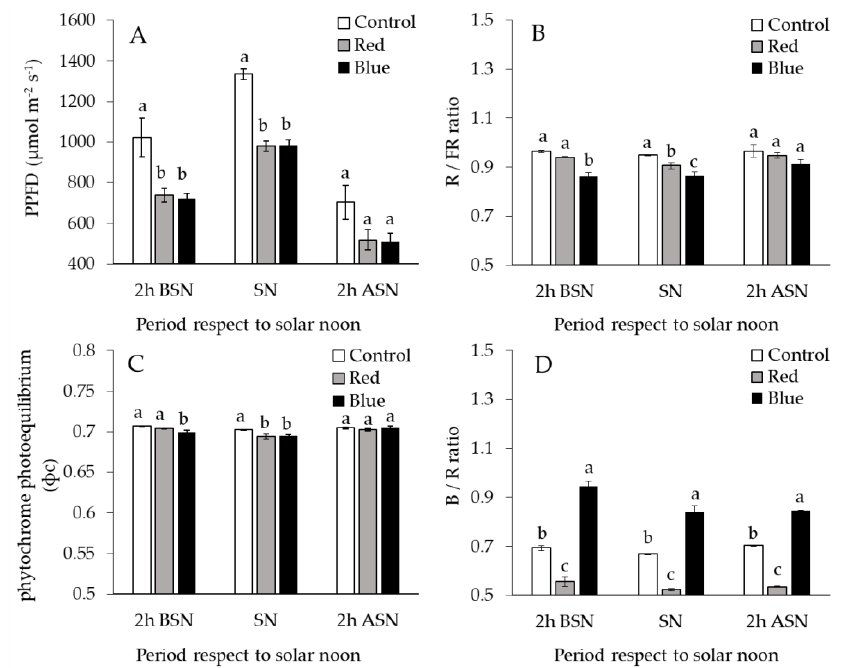
Figure 1. ( A ) The influence of red and blue netting on total photosynthetic photon flux density, PPFD, ( B ) red to far-red light ratio, R/FR, ( C ) phytochrome photoequilibrium, Φ c , ( D ) blue to red light ratio, B/R under solar ambient conditions; 2h BSN: Two hours before of solar noon; SN: solar noon; 2h ASN: Two hours after solar noon. Columns with different letters are statistically significant by the LSD Fischer test; n = 4. µmol m −2 s −1 nm −1 greater than under the red net (Figure 2). Blue net reduced on average 1.6 µmol m −2 s −1 nm −1 the radiation transmission in the red spectrum (600–700 nm) compared to red net (Figure 2).